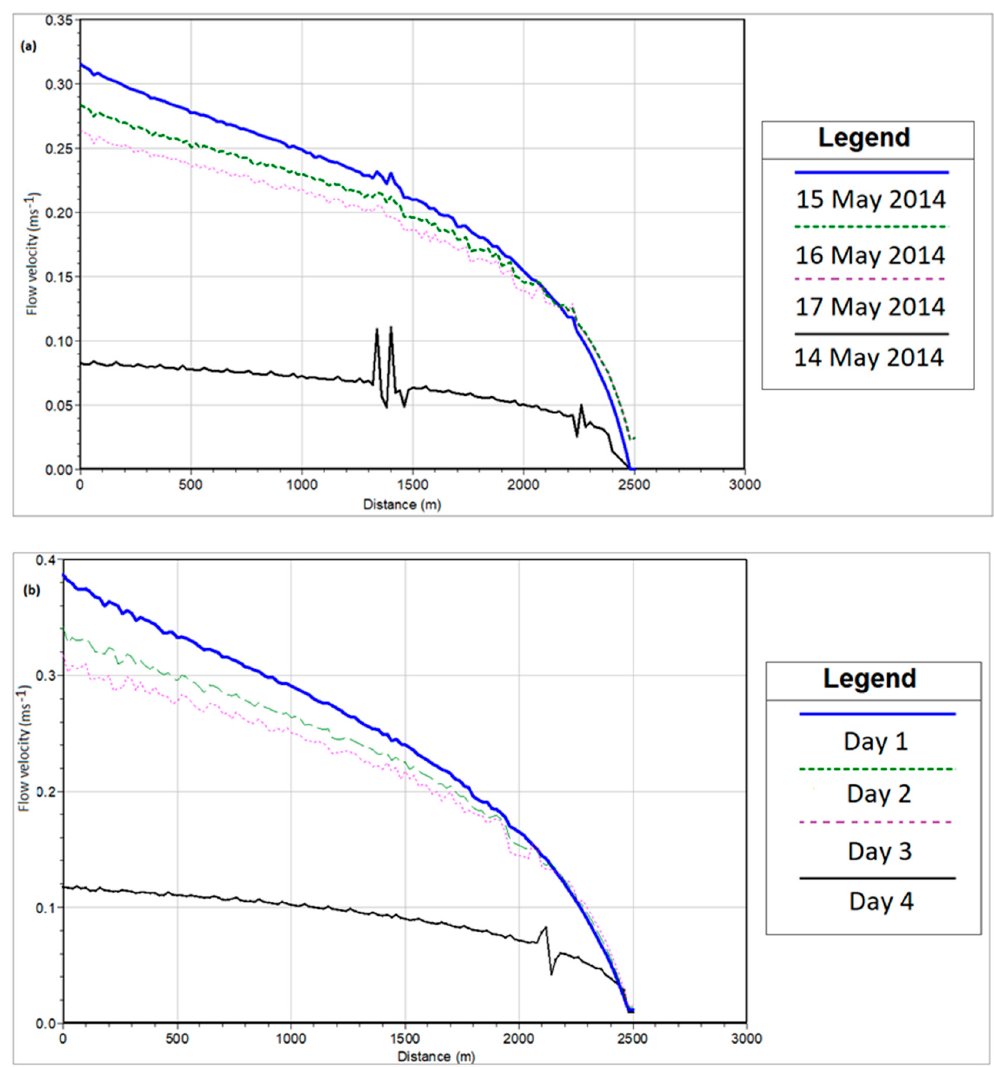
Figure 7. Flow velocity in the canal during the precipitation episode between 13 May and 20 May 2014 ( a ) and flow velocity in the canal calculated for design precipitation episode of 50-years return period ( b ).